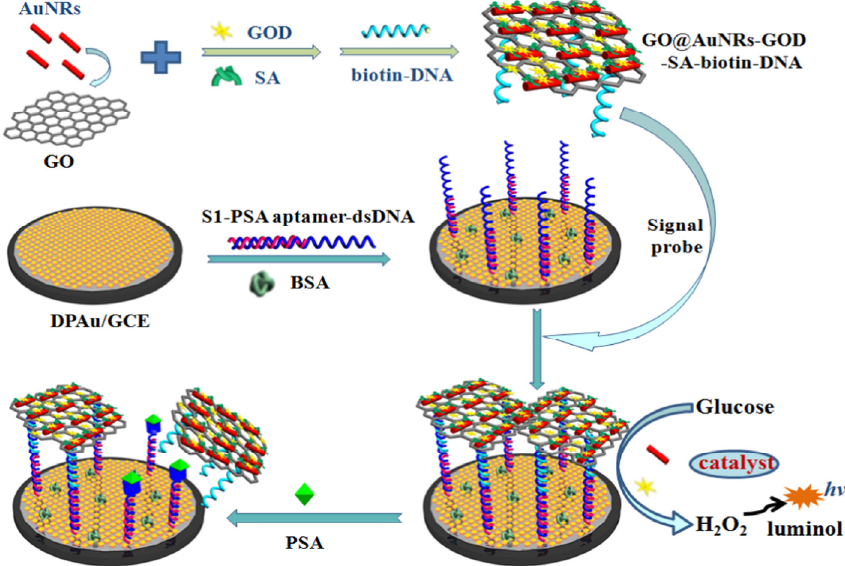
Figure 23. Working principle of biosensor for electrochemiluminescent detection of PSA using GO@AuNPs-glucose oxidase-DNA nanocomposite. Adapted with permission from Cao et al. [132] (copyright © (2018), Elsevier).